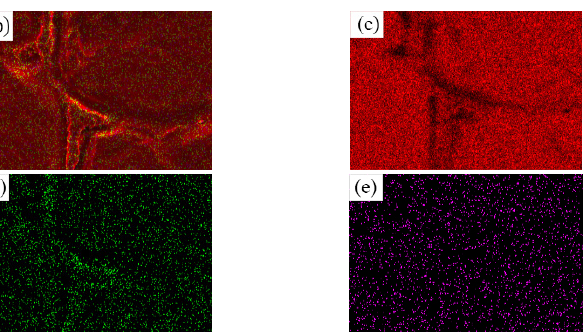
9 of 11 Figure 10. SEM/EDS images for OABs of aluminum alloy wires with a 160 A overcurrent: ( a ) SEM image; ( b ) total element mapping; ( c ) Al mapping; ( d ) Fe mapping; ( e ) Si mapping. Figure 9 shows that the metallographic structure of the aluminum wires OABs has coarse grain boundaries. Figure 11 presents the microscopic morphology and mapping of the OABs of the aluminum wires with a 160 A overcurrent. Figure 11a shows that the aluminum wires OABs have precipitate phases at the grain boundaries. Figure 11b,c shows that the precipitate phases at the grain boundaries are α -Al, and the distribution of elements between the grains and the grain boundaries of the aluminum wires is uniform. Since the grain boundary energy is lower, the solute aggregates at the grain boundaries.